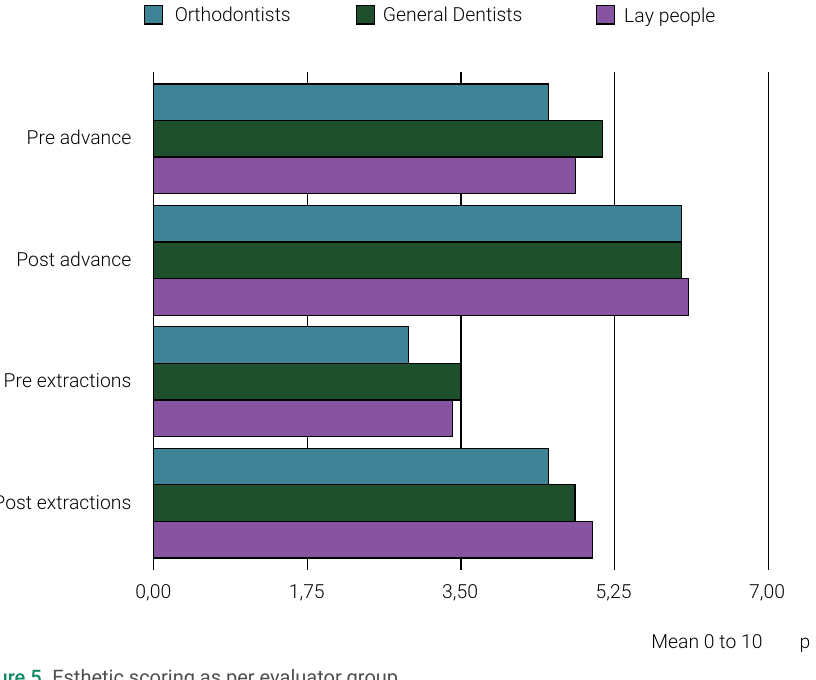
Figure 5. Esthetic scoring as per evaluator